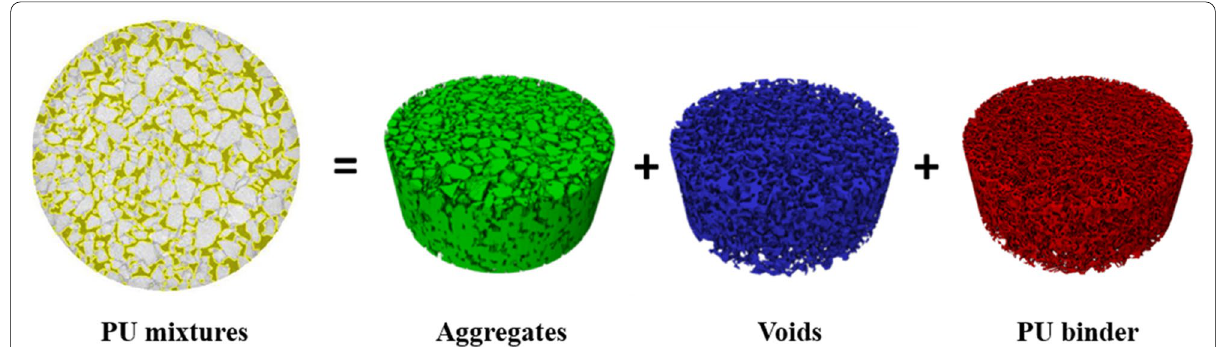
Fig. 2 The composition of PU